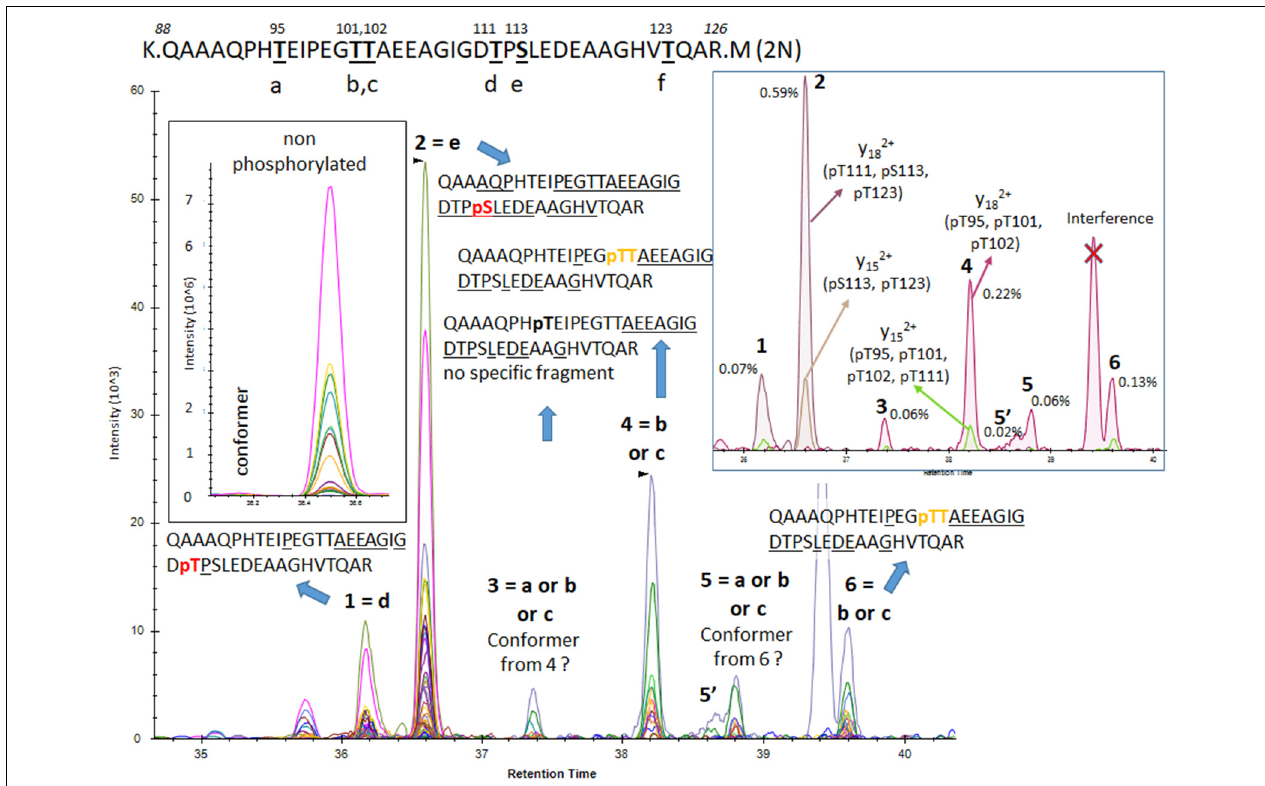
FIGURE 5 | PRM screening of mono-p-tau sequence 88–126 (2N isoform). Six potential phosphorylation sites are located in this sequence and six LC-MS patterns were identified. Fragments found in pattern 1 and 2 were consistent with phosphorylated peptides at residues T111 (d) and S113 (e), respectively. No specific fragment from the phosphorylated peptide at residue T123 (f) was found. Patterns 4 and 6 contained a low signal of the y29 fragment matching with phosphorylation on residue T101 (b) or T102 (c), but no specific fragment able to differentiate them was detected. Patterns 3 and 5 shared fragments found in patterns 4 and 6 but in lower abundance, locating the phosphorylated residue at the N-terminus on residue G109. This could indicate the presence of an additional phosphorylated peptide, likely at residue T95 (a) or abundant conformers from peptides found in patterns 4 and